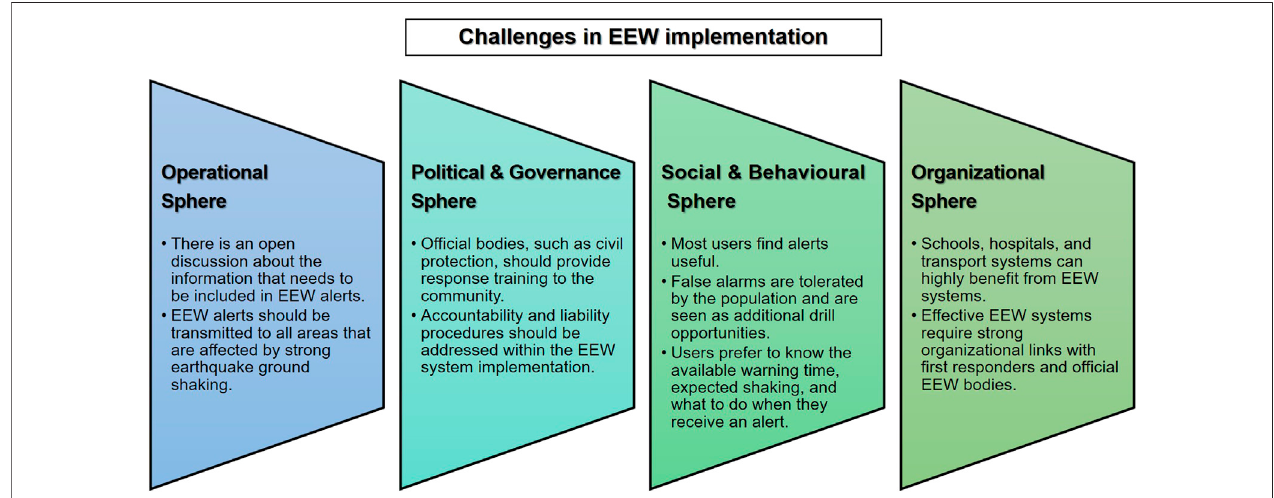
FIGURE 3 | Challenges in implementing earthquake early warning (EEW) systems: common fi ndings from the case studies, across all examined spheres.